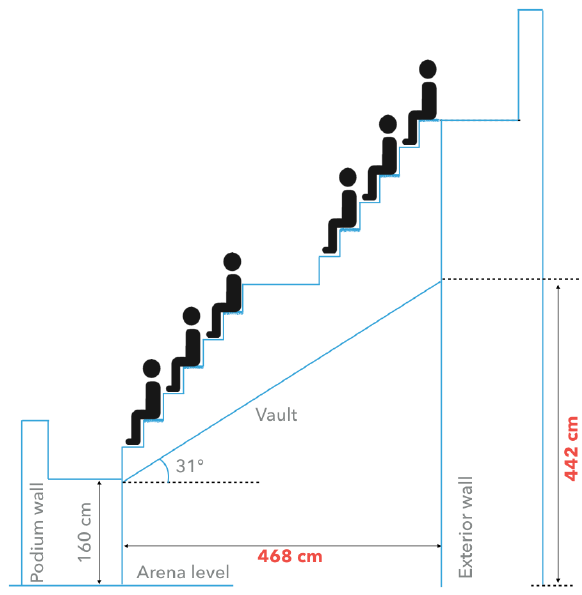
Figure 4. Hypothetical cross-section of the circus showing distribution of seats with a subdivision between different social classes according to the measurements coming out from the laser scanning campaign. In red the measurements taken on the field.